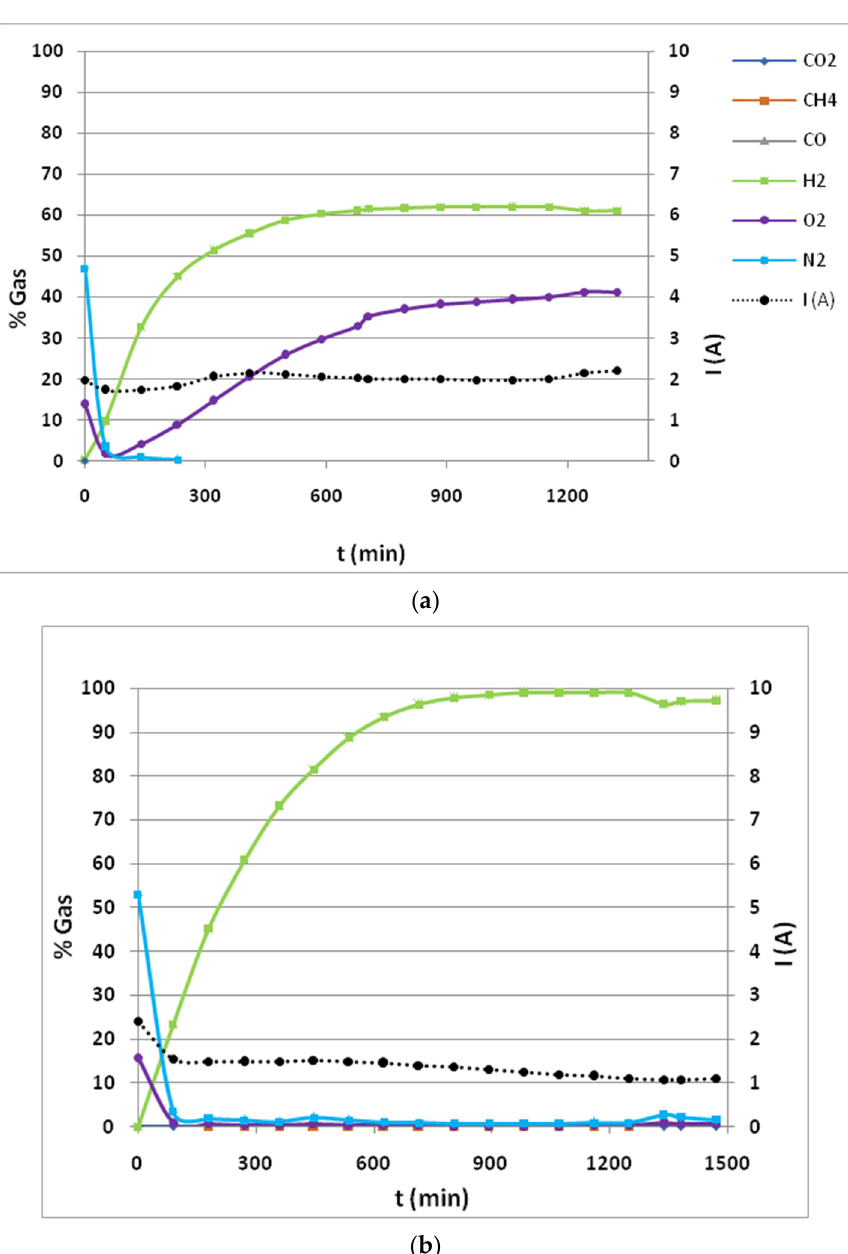
Figure 5. Temporal evolution of the generated gases (%) and of the electric current in the electro- oxidation process of an aqueous solution, with graphite electrodes at a constant voltage of 3V, of: ( a ) 1 M KOH electrolyte; ( b ) 1 M KOH electrolyte and 1M glycerol.